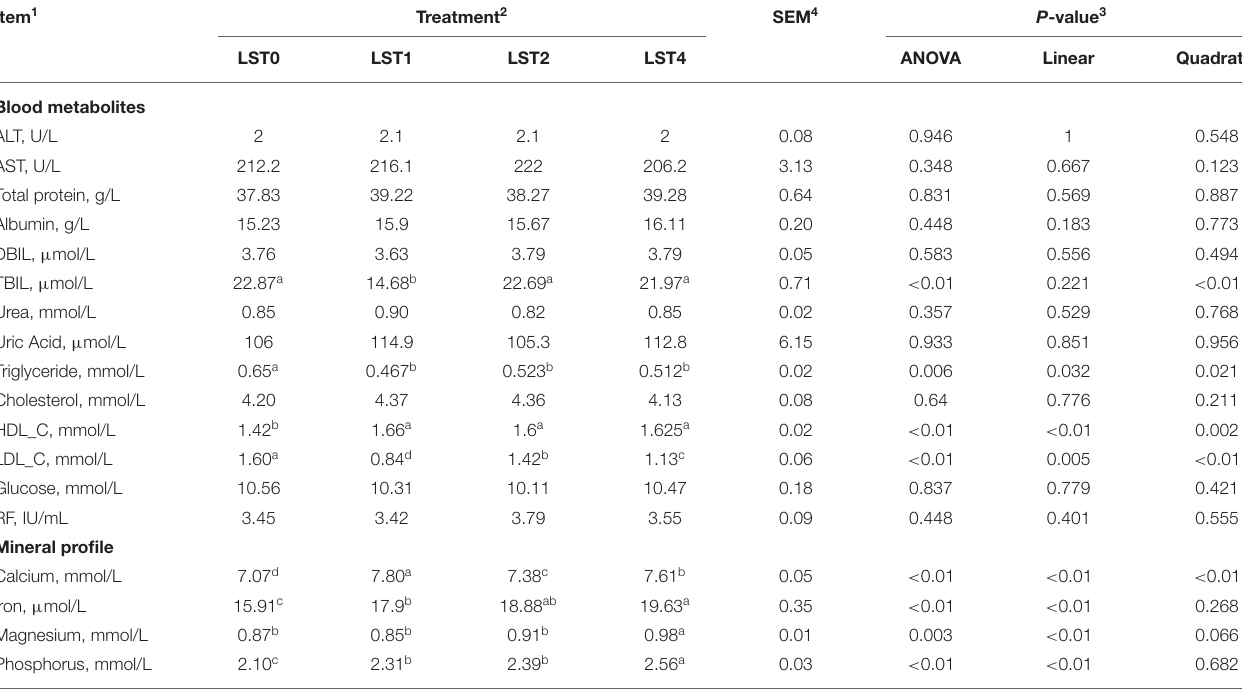
TABLE 4 | Effect of dietary LST powder supplementation on blood metabolites and mineral profile of broiler chickens ( n = 10). Item